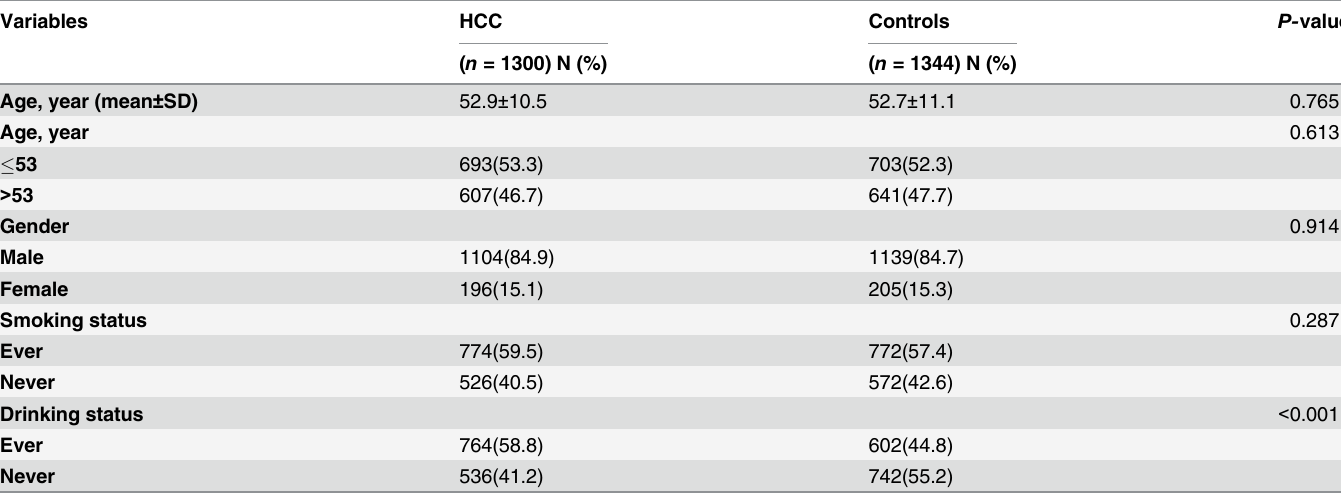
Table 2. Demographic and selected variables in HCC cases and